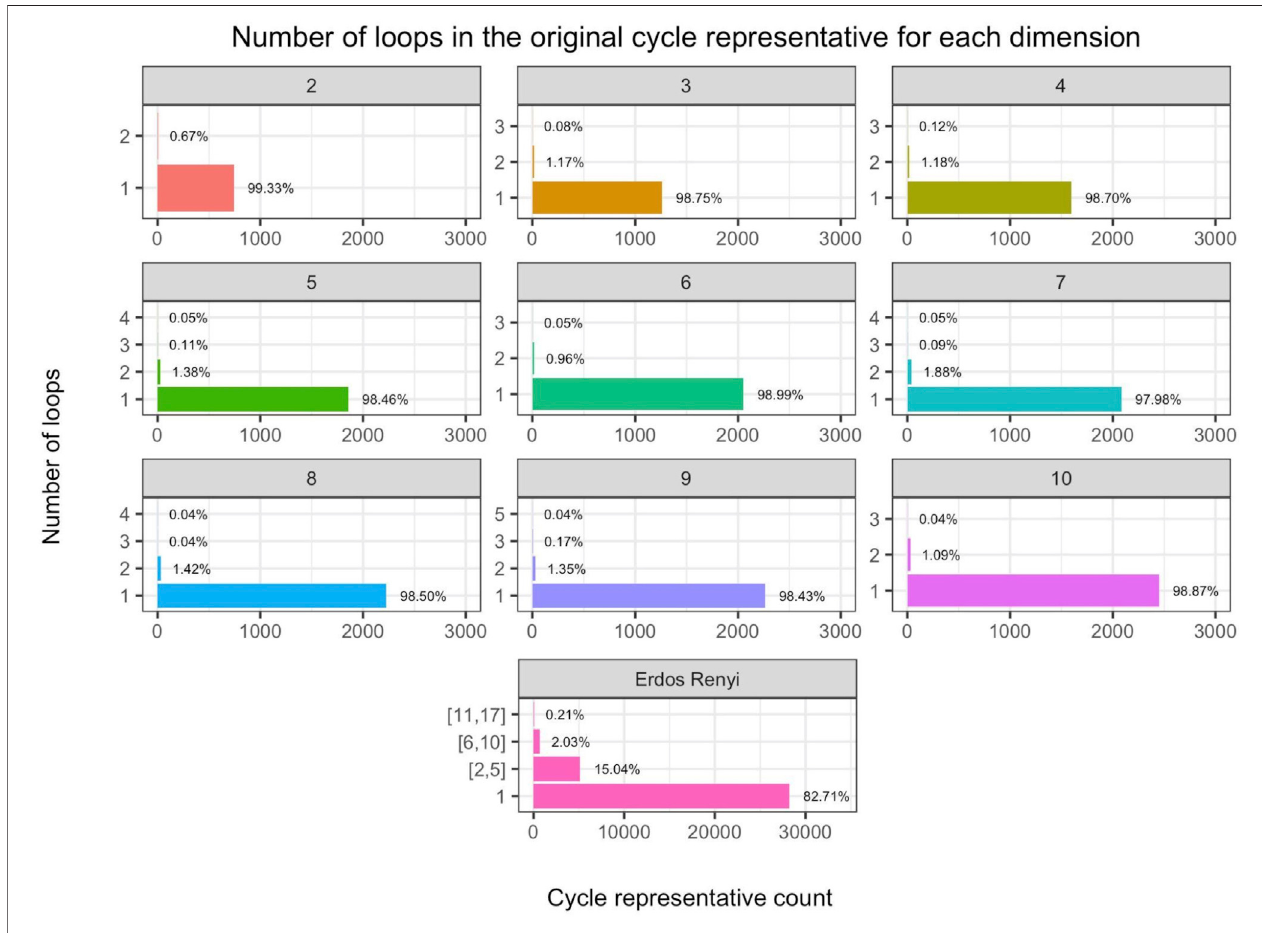
FIGURE 10 | (Rows 1 – 3) Number of loops in the original cycle representative aggregated by dimension (labeled by sub fi gure title) in the 360 randomly generated distributiondatasetsdiscussedin Section5.2 and (Row4)samefortheErd } os-Rényirandomcomplexesdiscussedin Section5.3 ,wherewebincyclerepresentatives thathavetwoto fi veloops,6 – 10,loops,ormorethan10loops.Thehorizontalaxisisthenumberofcyclerepresentativesandtheverticalaxisisthenumberofloopsinthe original representative. We observe that for the distribution data, an original cycle representative can have up to 5 loops in higher dimensions, and in general, it is uncommon to fi nd an original representative with multiple loops. However, we observe that 17 . 47% of the cycle representatives for Erd } os-Rényi complexes have more than 1 loop, with a maximum number of 17 loops in a cycle